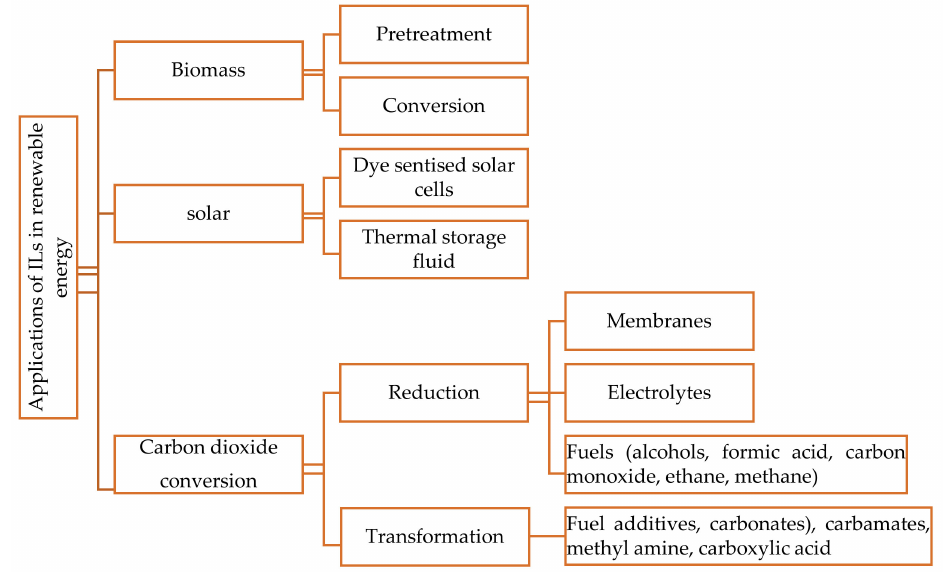
Figure 1. Applications of ionic liquids in renewable